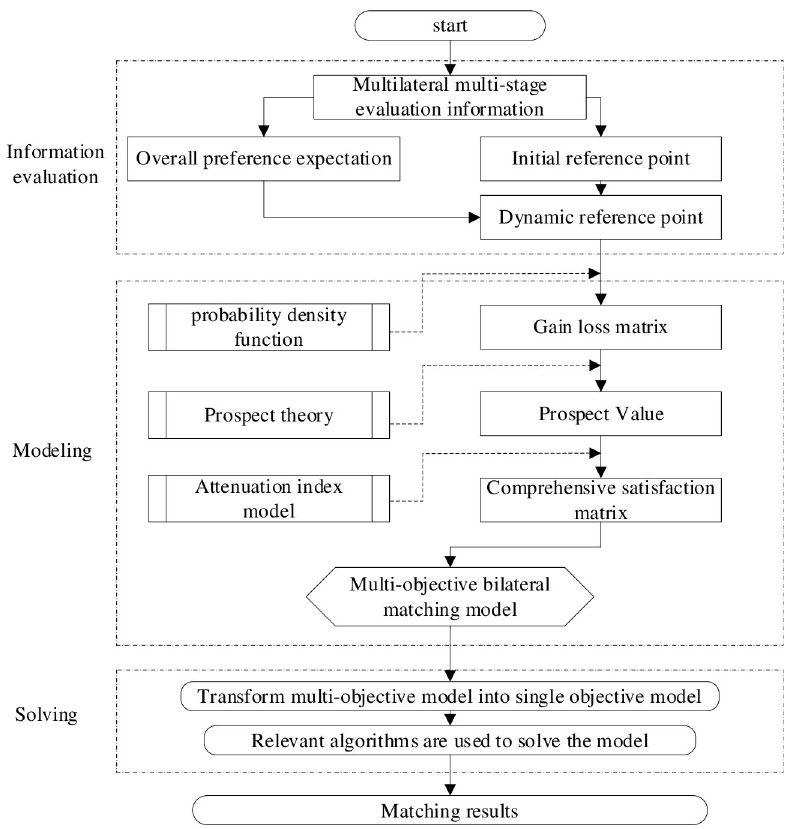
Fig 3. Solution steps of three-sided dynamic